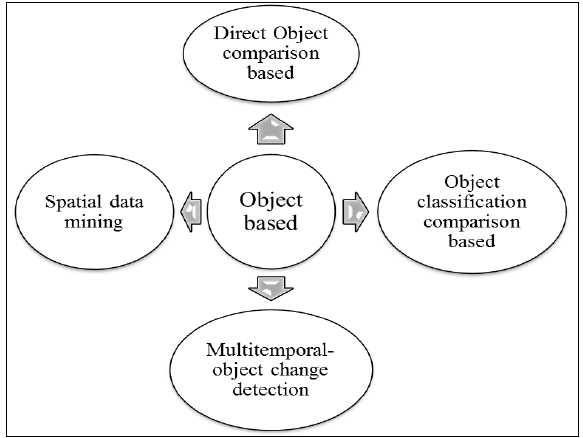
Figure 2, Overview of different object based change detection